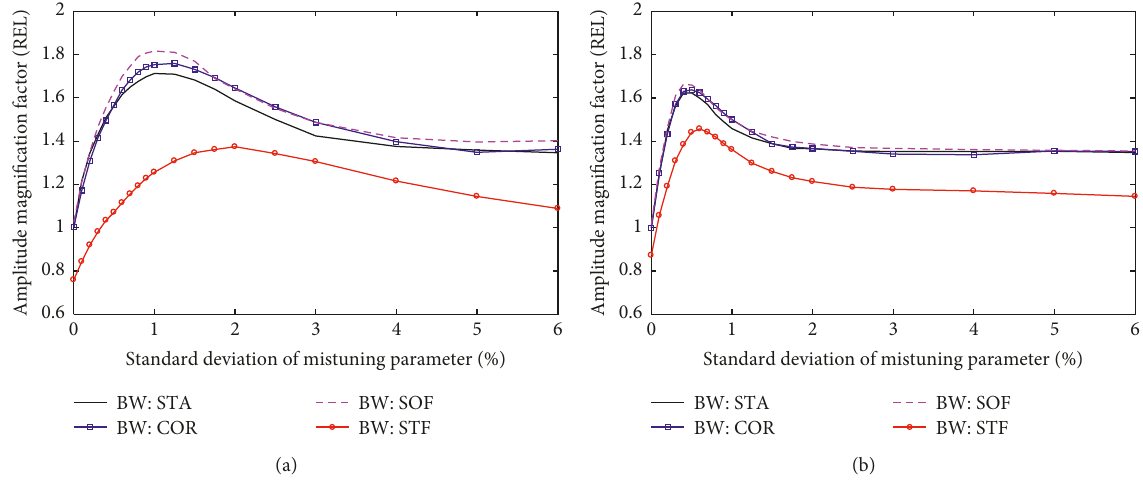
Figure 17: 95 th percentile of relative AMF versus standard deviation of mistuning parameter under the action of (a) 3EO and (b) 4EO backward traveling wave excitations. Monte Carlo simulation of 2000 mistuning patterns generated by uniform distribution of mean 0 is conducted for each